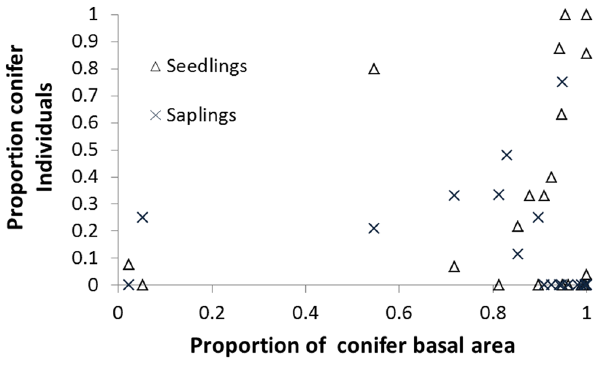
Figure 4. Conifer recruitment as a function canopy dominance. Twenty-eight forest plots within Jiuzhaigou National Nature Reserve plotting the proportion of conifer seedlings and saplings as a function of the proportion of total basal area accounted for by conifers. While the canopy of most plots consisted primarily of conifers, seedlings and/ or saplings in these plots were not necessarily predominantly conifers. Plots with low abundance of conifers in the overstory generally had low abundance of conifer seedlings and